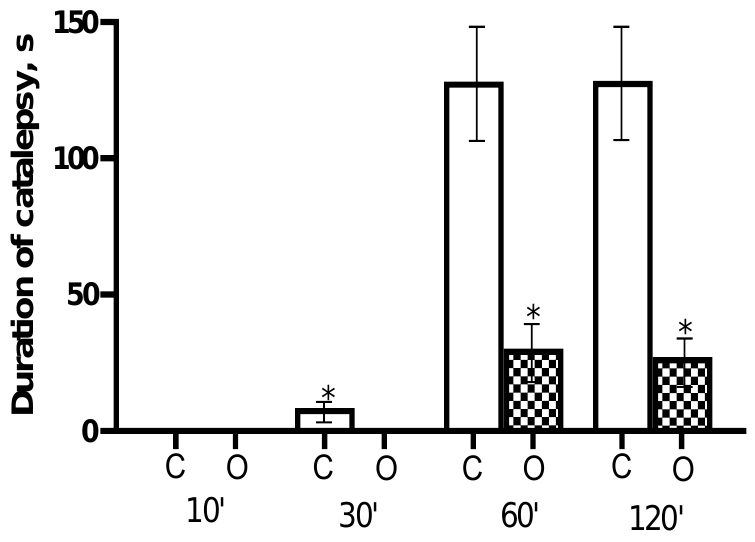
Figure 8. Indicators of the cataleptogenic action of haloperidol after intranasal administration to rats. On the abscissa axis — observation intervals (min) and groups of animals: C — control (haloperidol, 1 mg/kg; n = 8), O — experiment (nanoparticles with haloperidol, 1 mg/kg; n = 8). The ordinate is the duration of catalepsy in seconds. * — statistically significant differences at p < 0.05 (t — Student ’ s test).